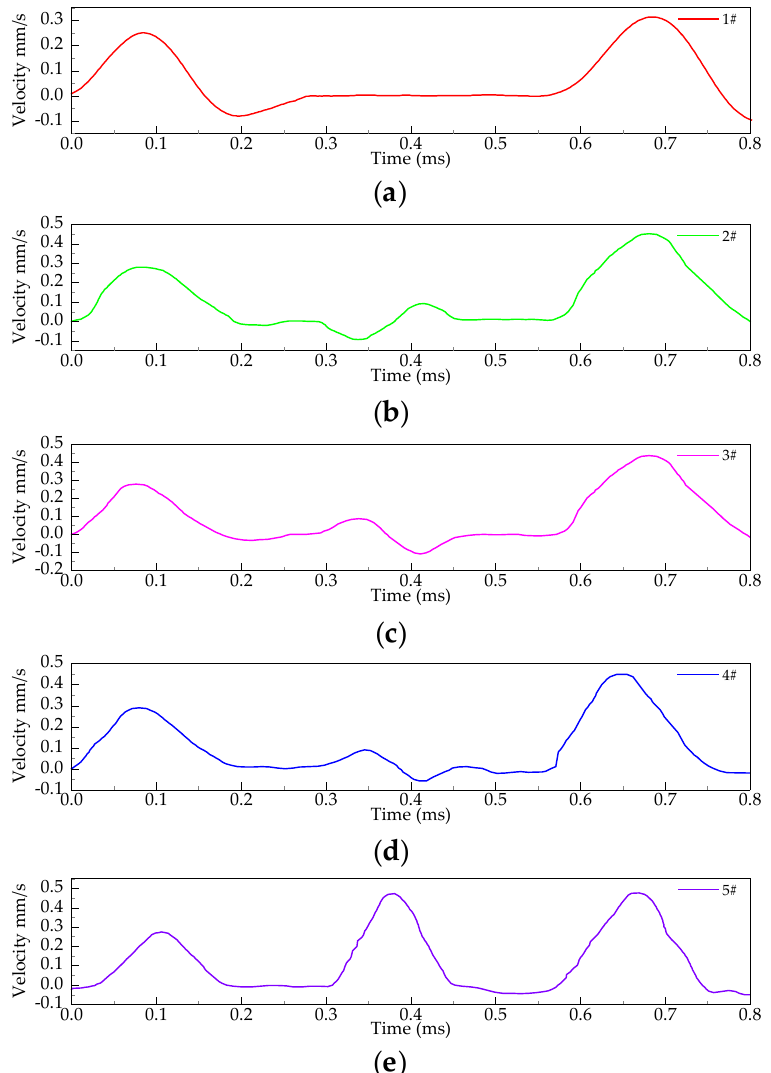
Figure 5. Model dynamic test results: ( a ) 1# model pile; ( b ) 2# model pile; ( c ) 3# model pile; ( d ) 4# model pile; ( e ) 5# model pile.